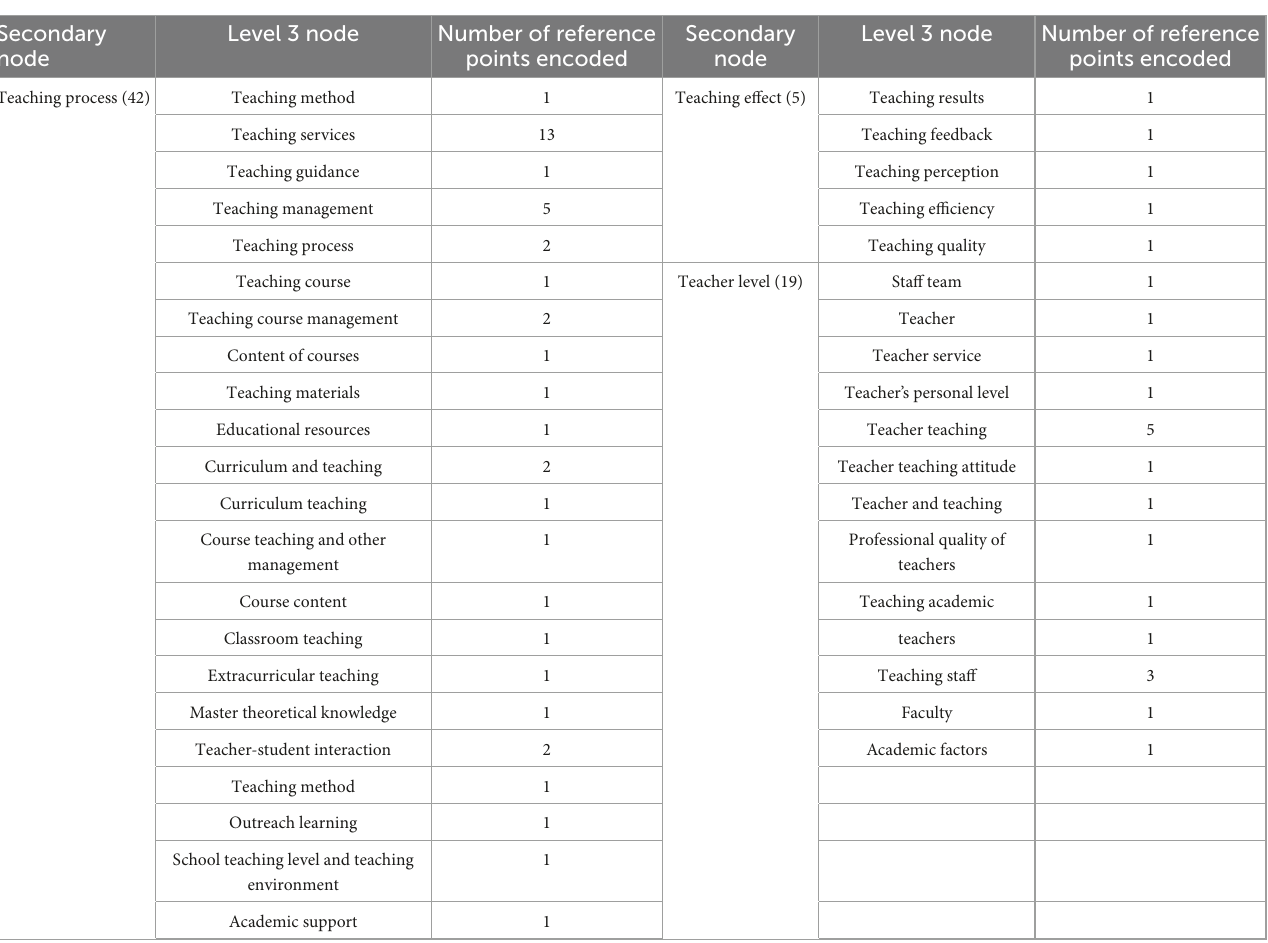
TABLE 2 Nodes and coding reference points in teaching